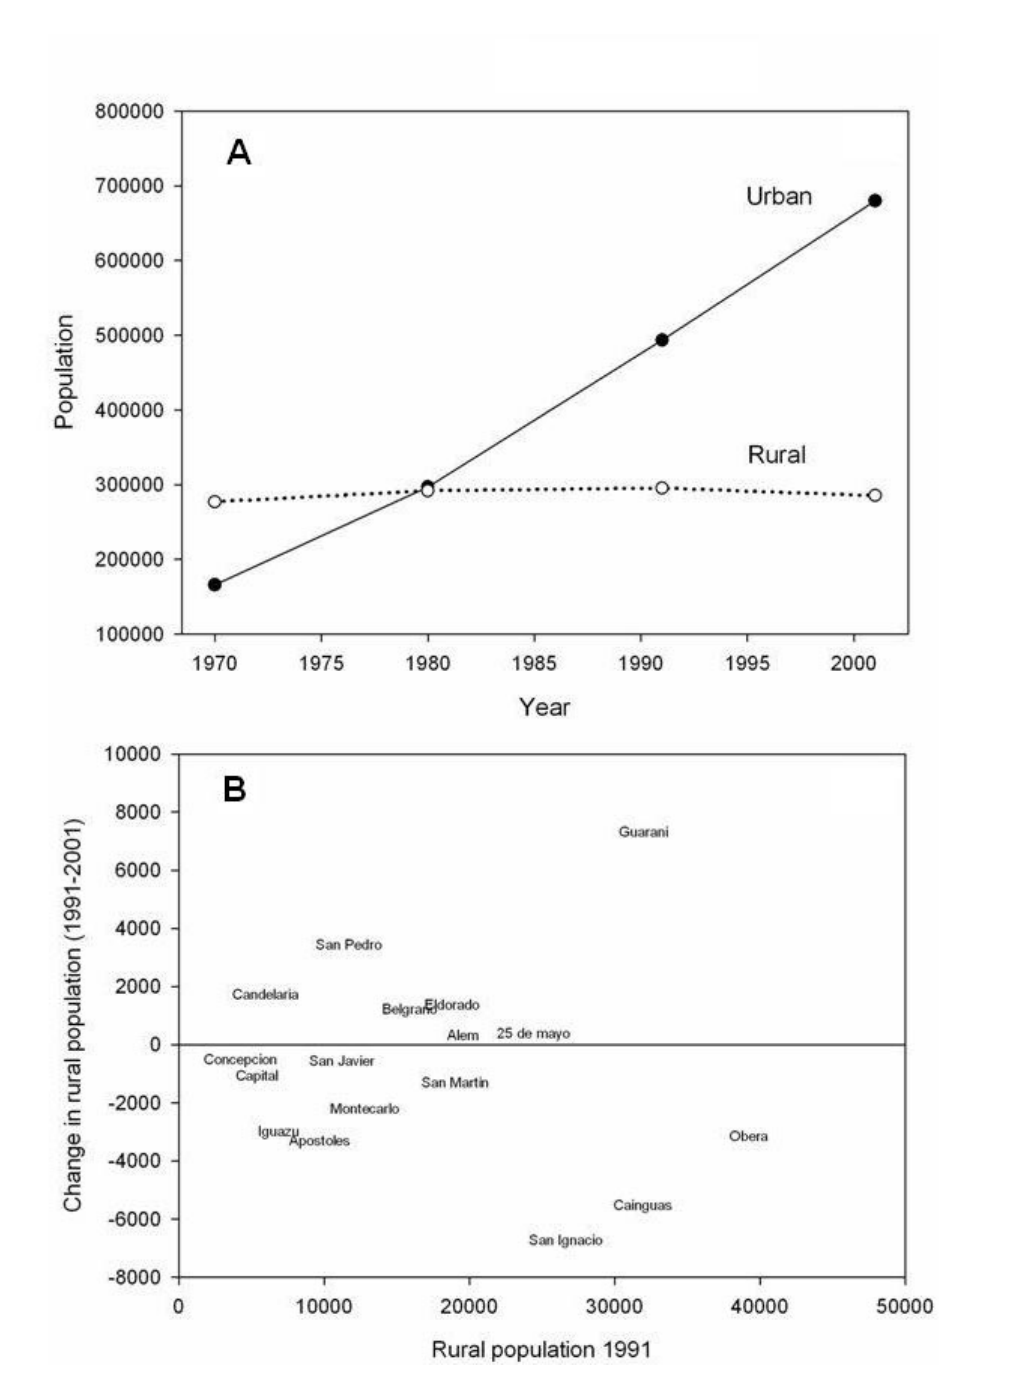
Fig. 3. (A) Change in rural and urban populations at the province scale. (B) The relationship between the change in the rural population between 1991 and 2001 and the rural population in 1991 for each